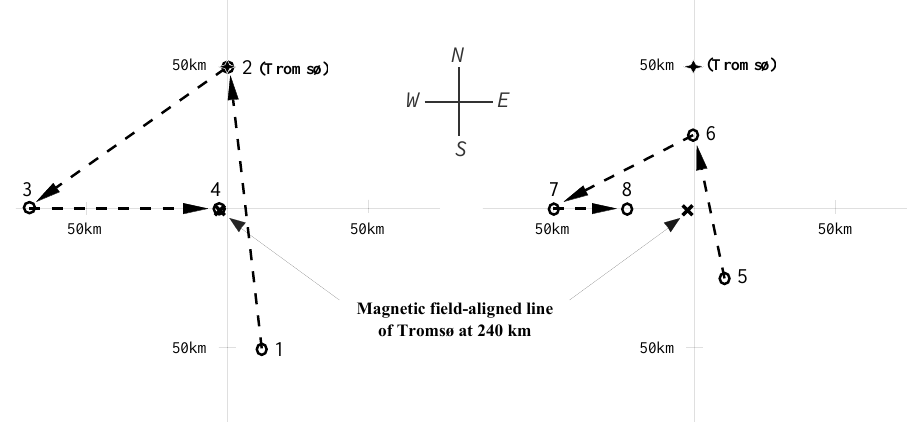
Fig. 2. Beam positions at 240km height in the mode employed, taking into account the Earth’s rotational effect. The spatial scale for electric field measurements at 240km height is 100km in the first set of beams (1–2–3–4), and 50km in the second set (5–6–7–8). The spatial scale for the conductance measurement becomes 50 (25)km in the first (second)